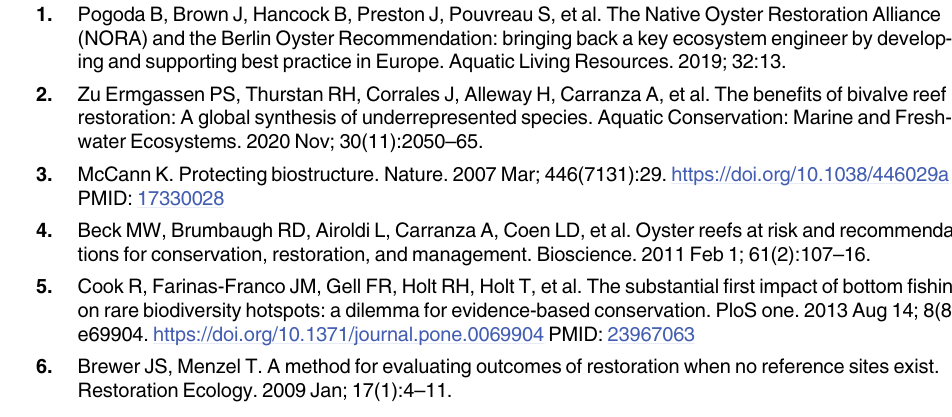
S1 Table. Species abundance data from treatment 1, 2 & 3 & S3 Table. Average oyster shell density and percentage cover data for treatments 1,2 &